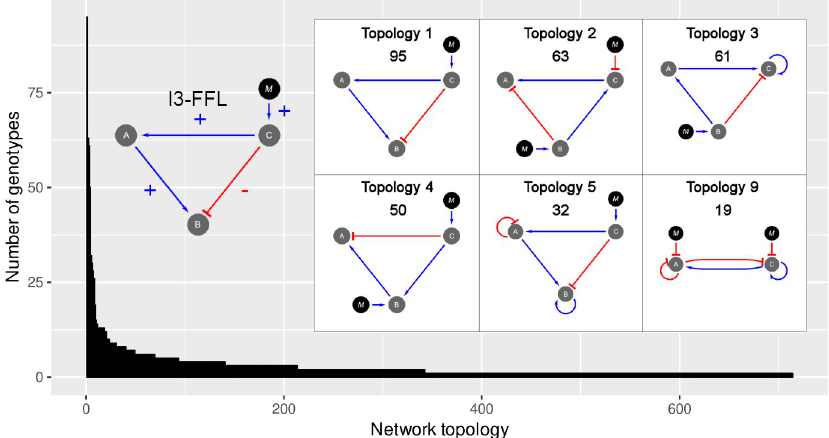
Fig 2. Distribution of abundances of network topologies. Some of the most frequent network topologies shown in the grid contain the I3-FFL network motif (shown on the left). In this network motif the gene B is activated in an indirect way by the morphogen through the activation of A (positive interactions), and at the same time, it is inactivated in a direct way by the morphogen (negative interaction). Topologies are numbered in order of decreasing abundance, being the Topology 1 the most abundant with a number of 95 genotypes. The number of genotypes belonging to each network topology is presented below the topology number. Note that network topology number 9 produces the striped phenotype using a two-node